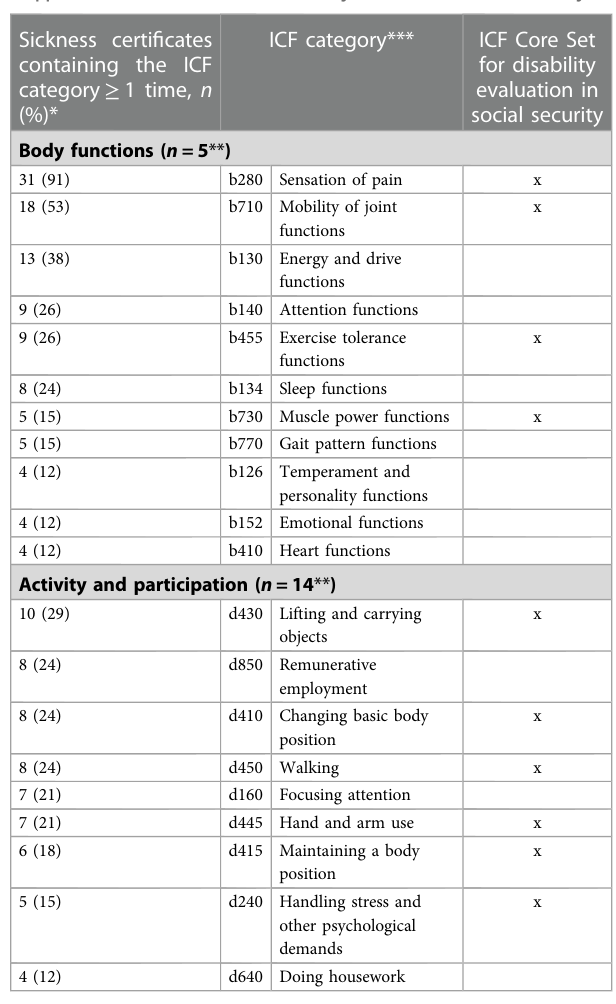
TABLE 4 ICF categories derived from sick leave certi fi cates issued for long-term musculoskeletal pain ranked after relative frequency and mapped to the ICF Core Set for disability evaluation in social security.